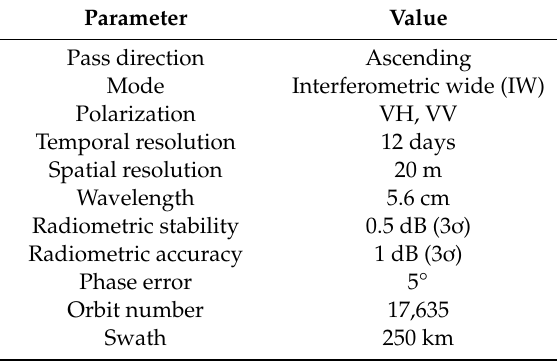
Table 2. Characteristics of Sentinel-1A